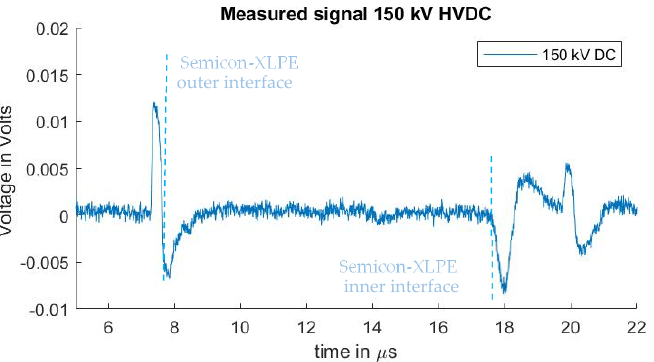
Figure 5. Measured signal with 150 kV HVDC without distortion (by means of subtracting a measure signal with no HVDC applied).